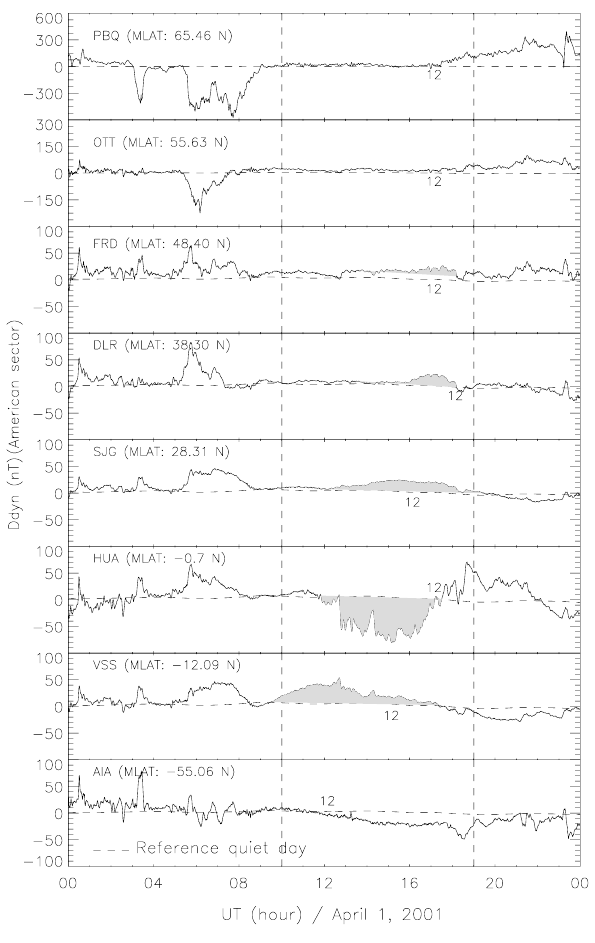
Fig. 10. Idem as Fig. 9, on 25 November